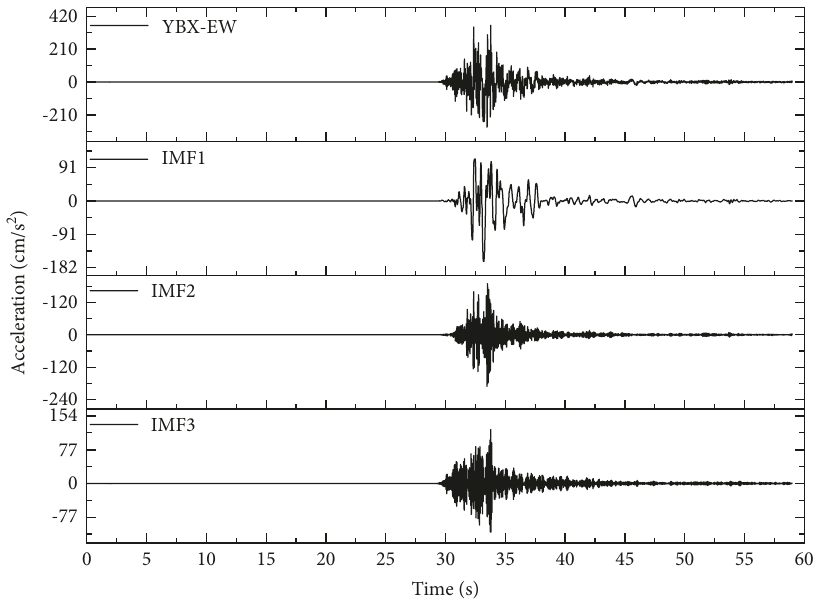
Figure 8: VMD result of the seismic signal (53YBX-EW).